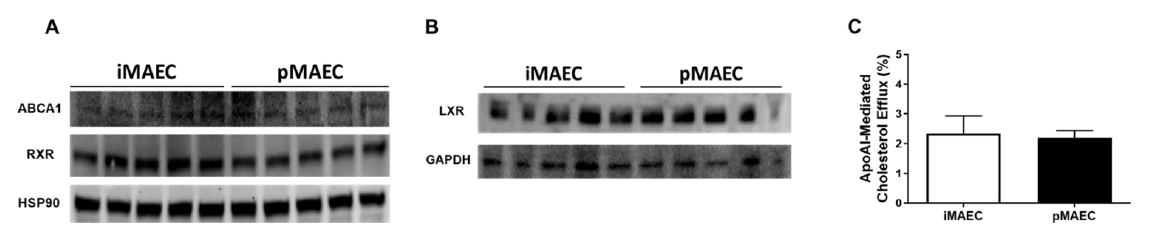
Figure 1. Detection of ABCA1, RXR, and LXR protein expression and quantifying cholesterol effluxed to apoAI in immortalized mouse aortic endothelial cells (iMAEC). ( A , B ) Protein detected via immunoblotting in iMAEC and primary mouse aortic endothelial cells (pMAEC; positive control) cultured in basal conditions for either ABCA1 and RXR ( A ) or LXR ( B ). Five replicates per cell type. HSP90 ( A ) and GAPDH ( B ) are housekeeping proteins. ( C ) ApoAI-mediated cholesterol efflux measured in serum-starved, [ 3 H]cholesterol-loaded iMAEC and pMAEC. Two independent experiments with three biological replicates per treatment for each experiment. Data are mean ± SEM.